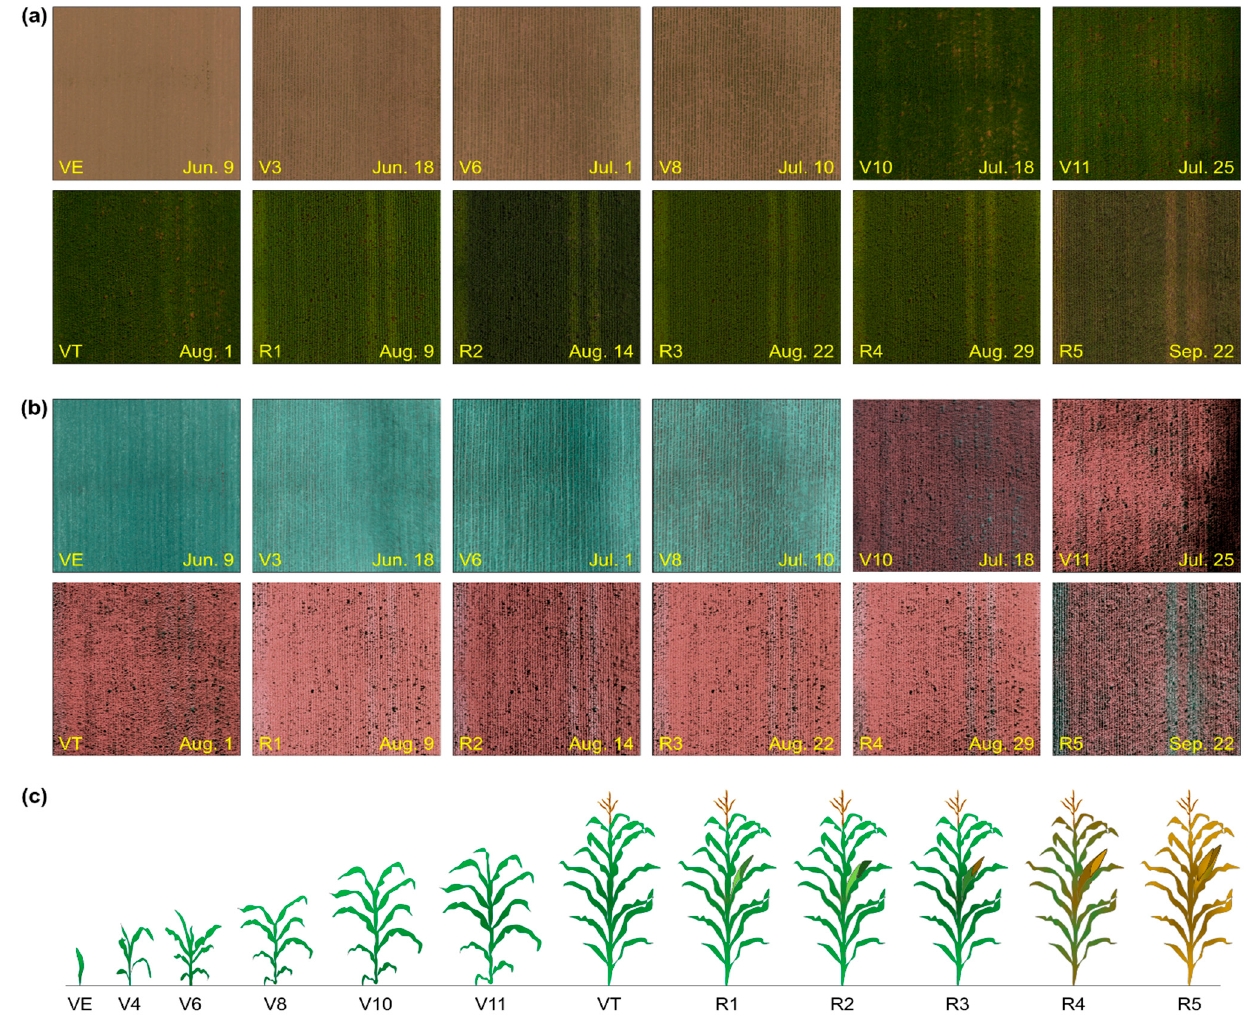
Figure 3. ( a ) Color imagery obtained using the RGB camera from a Quantix hybrid drone at different corn growth stages, from VE to R5; ( b ) false-color composite imagery obtained from the multispectral sensor, visualized by arranging the NIR-red-green layers as an R-G-B display; and ( c ) schematic representation of corn growth stages from VE to R5.